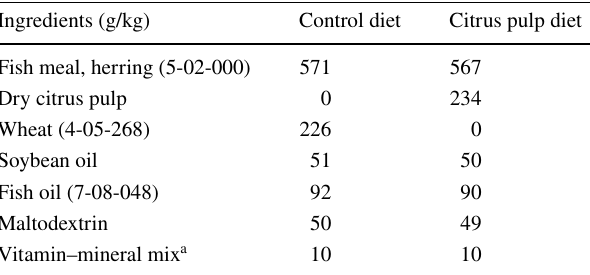
Table 1 Proximate composition of experimental